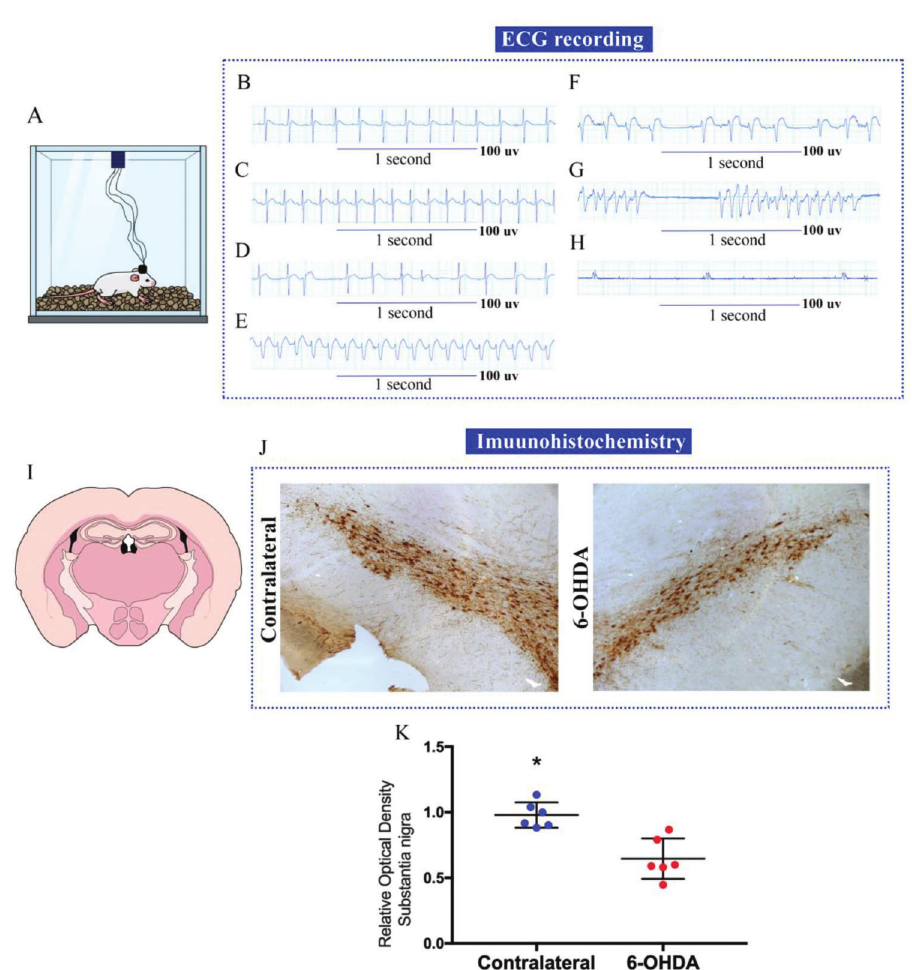
Figure 2 - Electrocardiogram (ECG) recordings from a Wistar rat submitted to 6-hydroxydopamine (6-OHDA) that died of sudden unexpected death in Parkinson ’ s disease (SUDPAR). (A) Animal in the Faraday cage for ECG recording; (B) Normal ECG, 3 days before death, with heart rate (HR) of 360 bpm; (C) ECG recording on the day of death with 480 bpm HR; (D) Evolution of ECG with the presence of ventricular extrasystoles, (E) ECG with 540 bpm ventricular tachycardia; (F) ECG with ventricular tachycardia and sinus block; (G) Torsades de Pointes , (H) ECG with absent electrical activity; (I) Image showing a slice of the striatum region of the animal; (J) Slice of the substantia nigra region of the brain showing dopaminergic neurons marked by the tyrosine hydroxylase antibody; (K) Analysis of the optical density of immunohistochemistry in the substantia nigra region. The asterisk (*) indicates a statistically significant difference between the two sides of the substantia nigra (* p o 0.05). The figure is created in the Mind the Graph platform